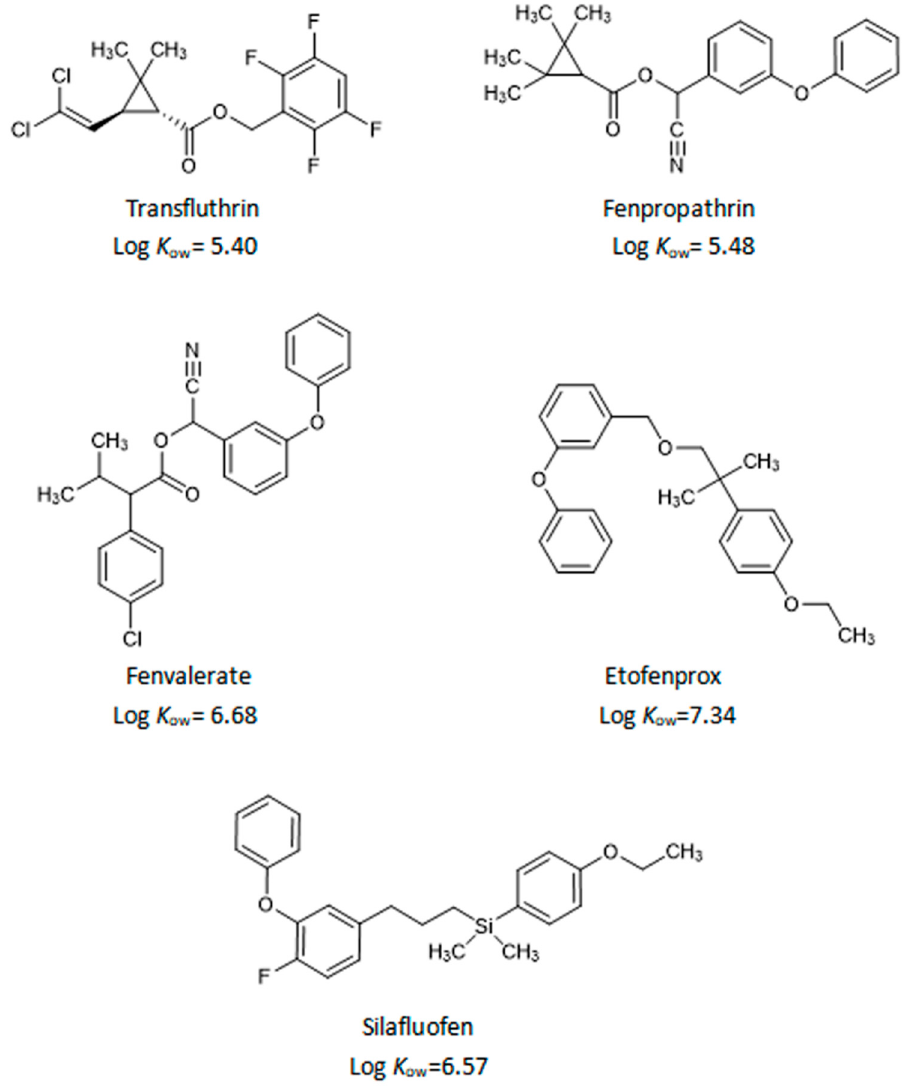
Figure 9. Chemical structures and Log K ow values of the five pyrethroids used in the study.